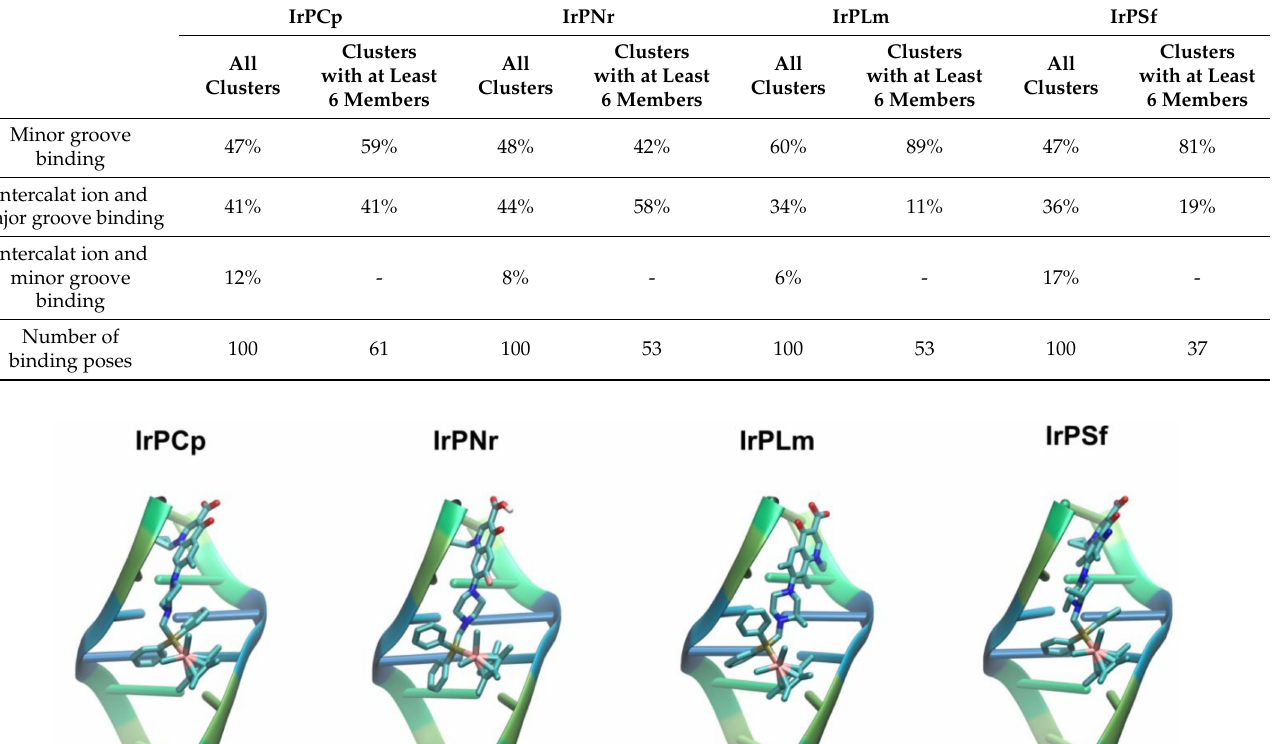
Table 2. The percentage of binding poses representing the particular binding mode in DNA-phosphino iridium(III) complexes for all the docking results (“All clusters”) or the largest clusters (“Clusters with at least six members”).